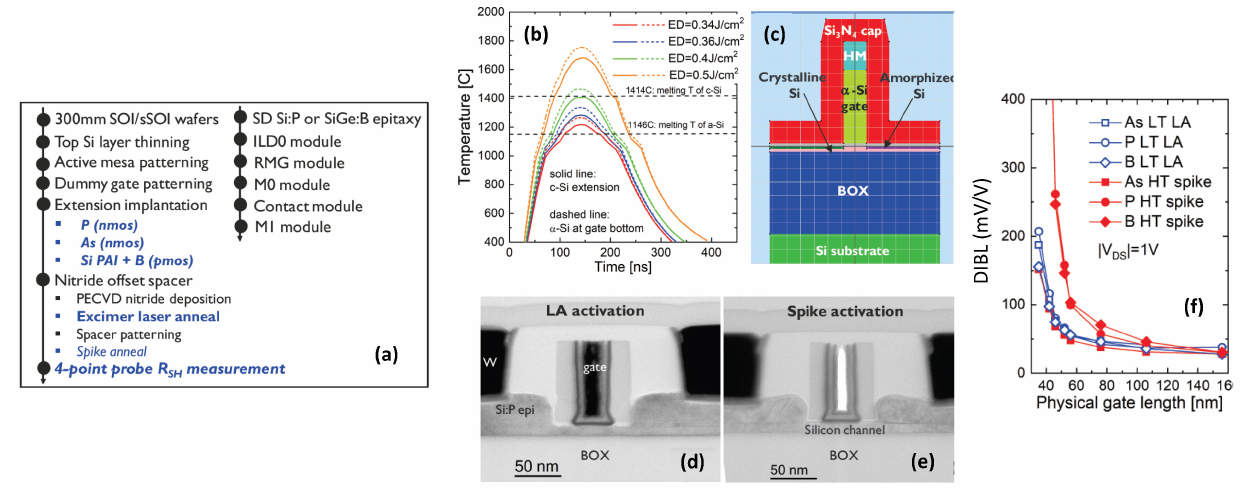
Figure 4. ( a ) Process flow of the FDSOI transistors treated by UV-LA; ( b ) Simulated time–temperature profiles of the applied UV-LA processes; ( c ) Structure used for the simulation; ( d , e ) Cross-sectional transmission electron microscopy (TEM) images of the EDSOI transistors after UV-LA and spike annealing; ( f ) DIBL extracted for different physical gate lengths. Reprinted/adapted with permission from Ref. [32]. 2020,